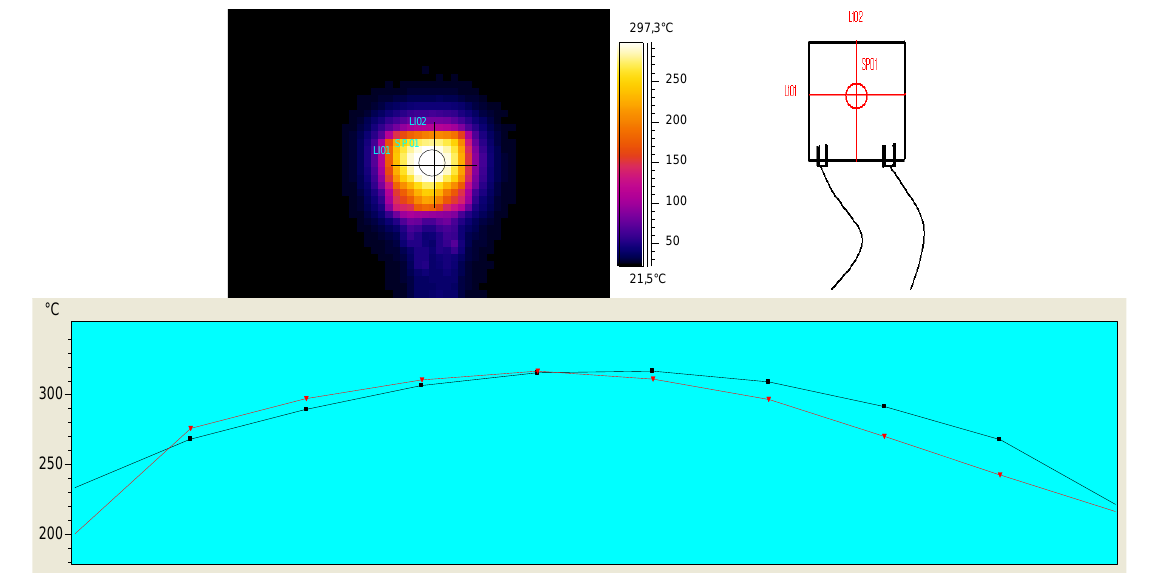
Figure 3. Temperature distribution on the surface of the film (top-left side) and temperature distribution (bottom) on the lines marked in the top-right chip